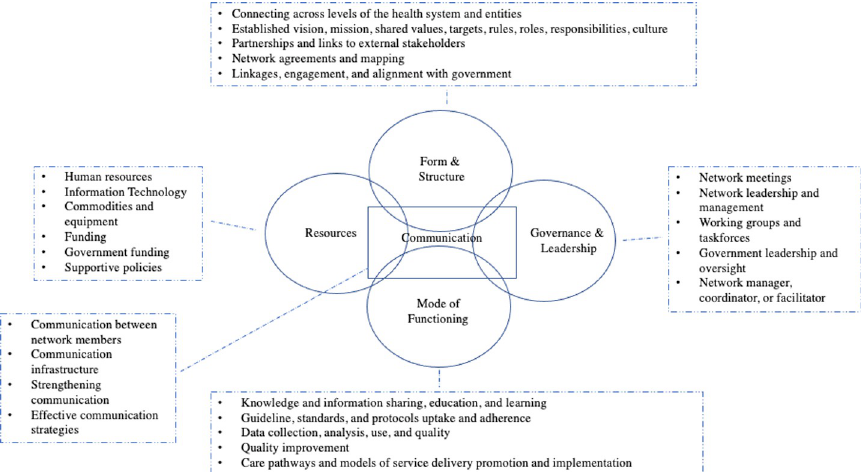
Fig 5. Proposed network framework: Components and key practical